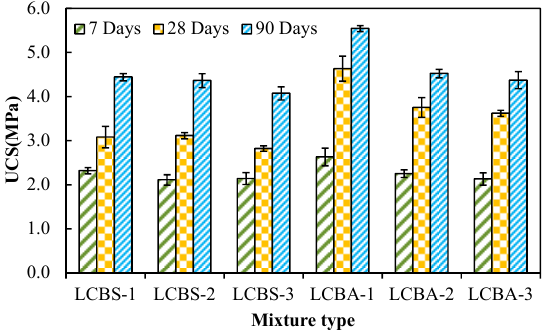
Figure 6. UCS of stabilized mixtures with different curing periods.